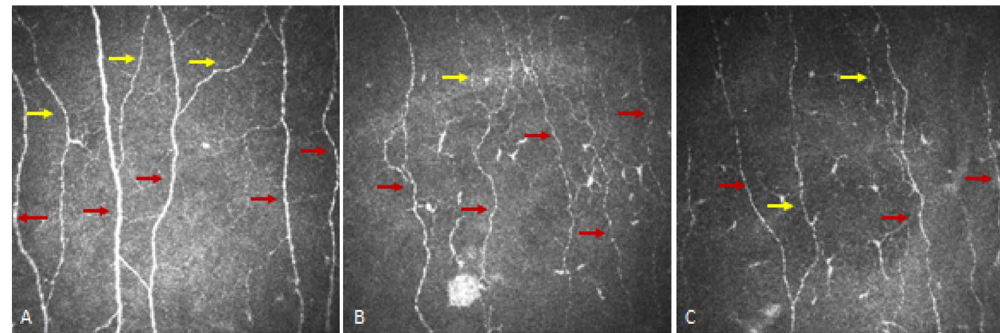
Figure 2. Corneal confocal microscopy image from a healthy control ( A ) and patient with diabetes at baseline ( B ) and follow-up ( C ) showing a progressive loss of nerve fibres (red arrows main nerves, yellow arrows branches) in patients with